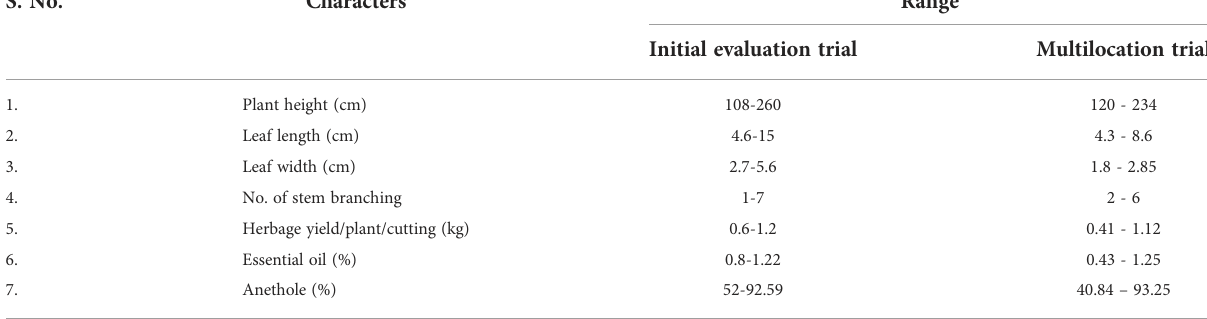
TABLE 1 Range for morphological and chemical data of C.heptaphylla germplasm in initial evaluation and multilocation trial. S.